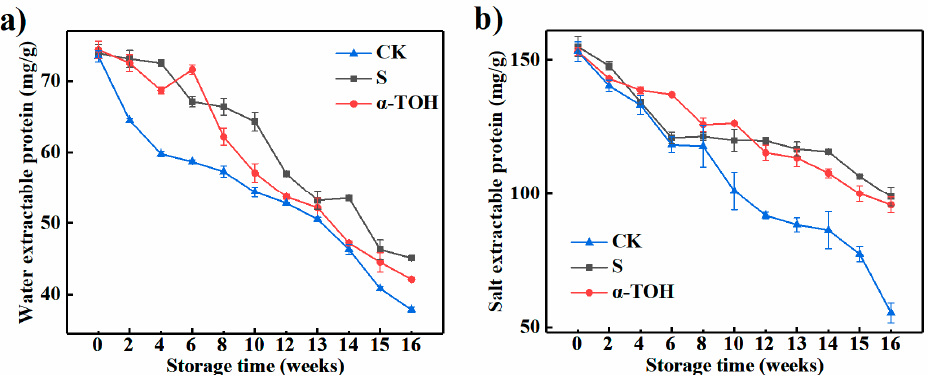
Figure 3. Effects of α -TOH on the water-extractable protein content ( a ) and salt-extractable protein content ( b ) of sturgeon surimi during 16-week frozen storage at − 18 °C. Bars represent the standard deviation from triplicate determinations ( n = 3; 3 means 3 replicates).